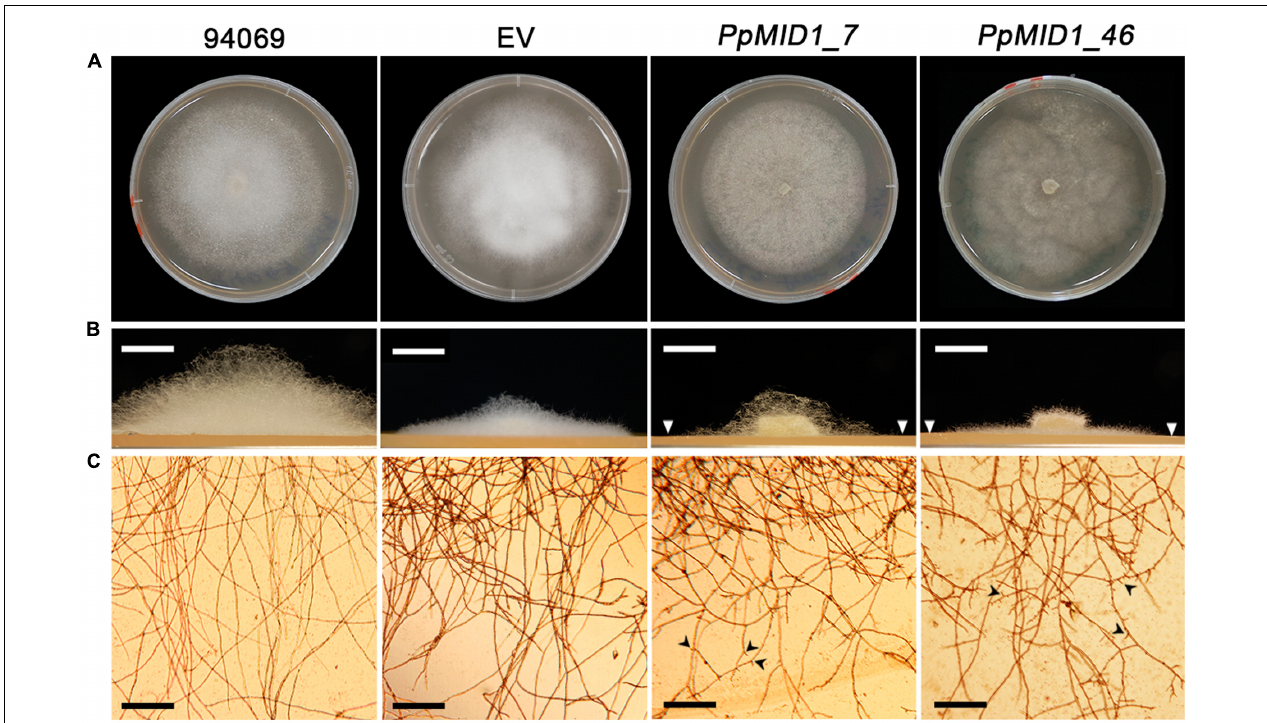
FIGURE 4 | PpMID1- silenced transformants produce less aerial mycelia and mycelia in liquid culture are highly branched. (A) Colony morphology. Photographs were taken 7 days after subculture. (B) PpMID1- silenced transformants produced less aerial mycelia on solid medium. Mycelia disks (5 mm id.) of silenced transformants ( PpMID1_7 and PpMID1_46 ), EV, and wild-type Phytophthora parasitica (94069) were transferred to 20% V8 juice agar and grown in the dark at 25 ◦ C. Photographs for the side view of each colony were taken 3 days after subculture. Arrowheads, colony margins of silenced transformants. Bar = 5 mm. (C) Mycelia produced by PpMID1- silenced transformants in liquid medium are highly branched. Mycelia disks (5 mm id.) of PpMID1_7 , PpMID1_46 , EV, and the wild type (94069) were transferred to 20% V8 juice medium and grown at 25 ◦ C in the dark. Photographs were taken under a microscope 1 day later. Arrowheads, branched hyphae. Bar = 100 µ m.